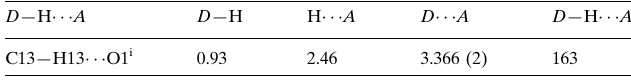
Hydrogen-bond geometry (A˚ , (cid:2)